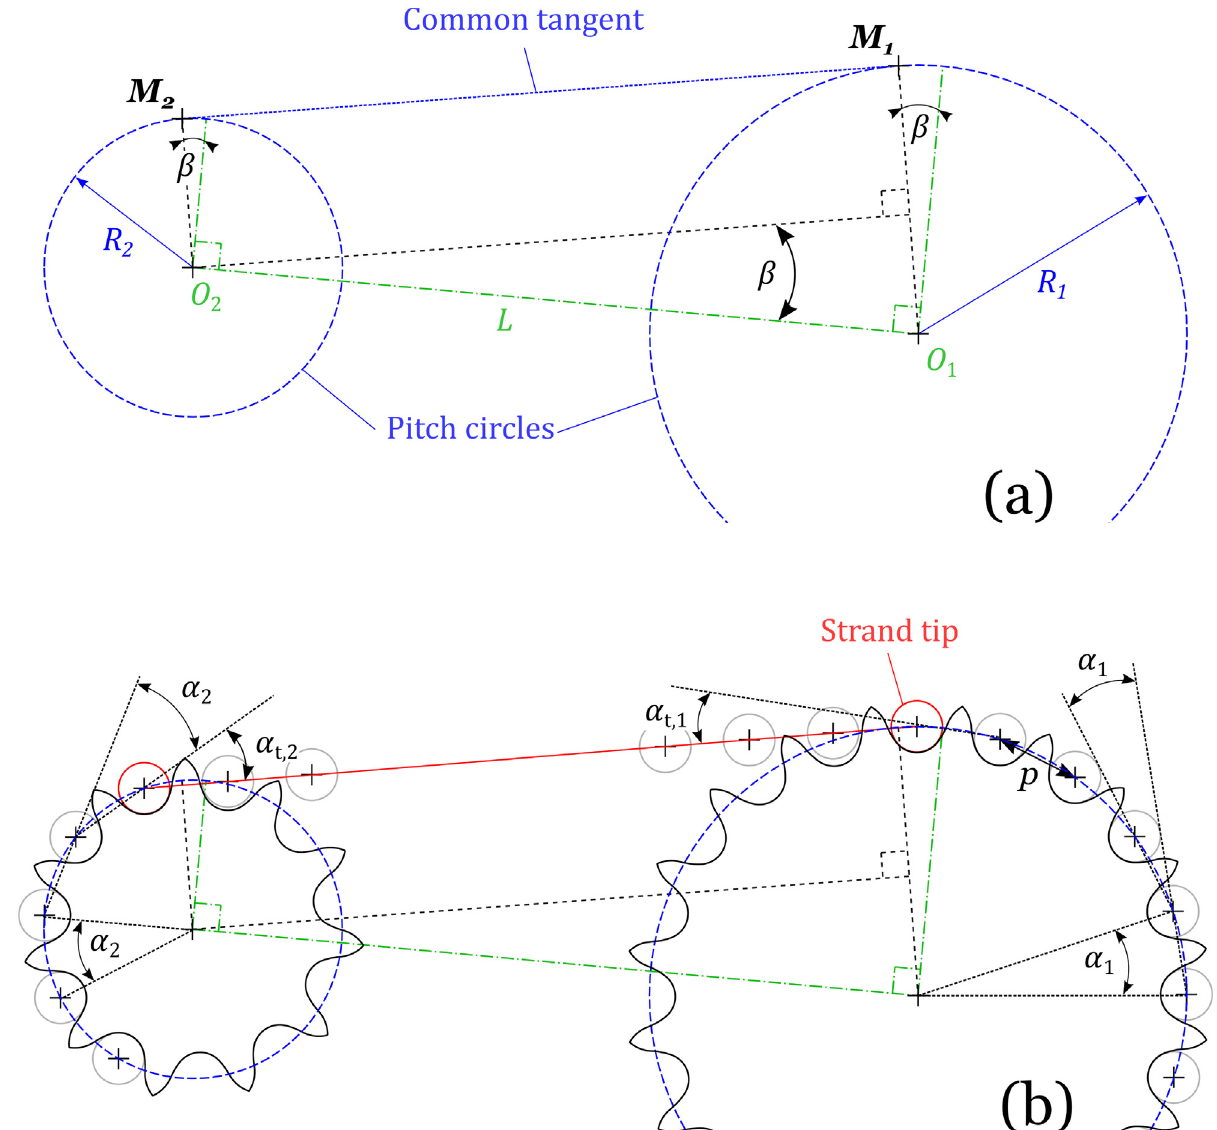
Fig. 3. Basic de fi nition of chain drive